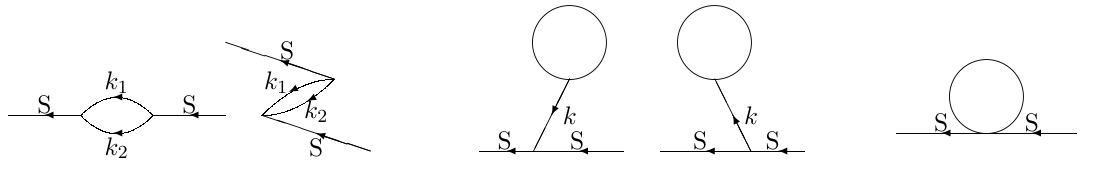
Figure 1 . The first two diagrams give µ (1) (S) . The next two are equal and sum to µ (2) (S) . The last diagram is µ (3) (S) . µ (4) (S) is found by replacing one k in the first two diagrams with a zero mode. A loop factor I ( x ) arises for each loop at a single